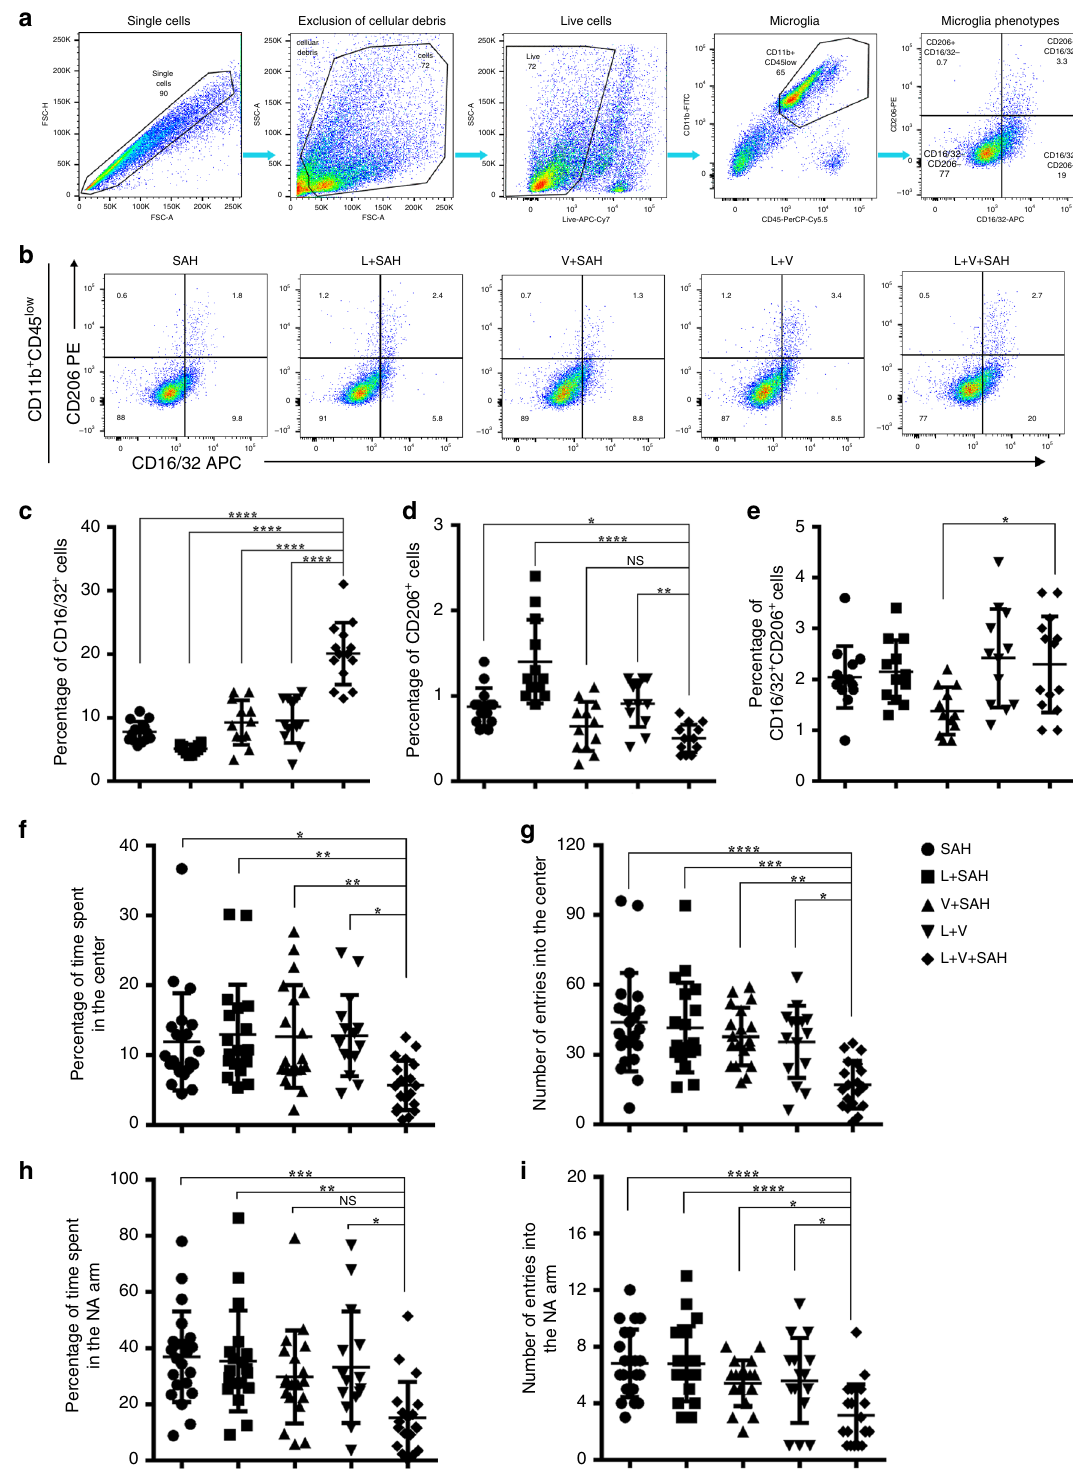
signi fi cantly greater percentage of meningeal lymphatics labeled by AF 488 anti-Lyve-1 (i.c.m.) was seen in the SAH group vs the controls ( P = 0.0122, Con vs SAH; P = 0.0303, Saline vs SAH; Fig. 6a – c), and all the lymphatics labeled by injected antibody were seen on the transverse sinus. A greater percentage of lym- phatics labeled by AF 488 anti-Lyve-1 (i.c.m.) also could be seen in dCLNs in the SAH group vs controls ( P = 0.0183, Con vs SAH;